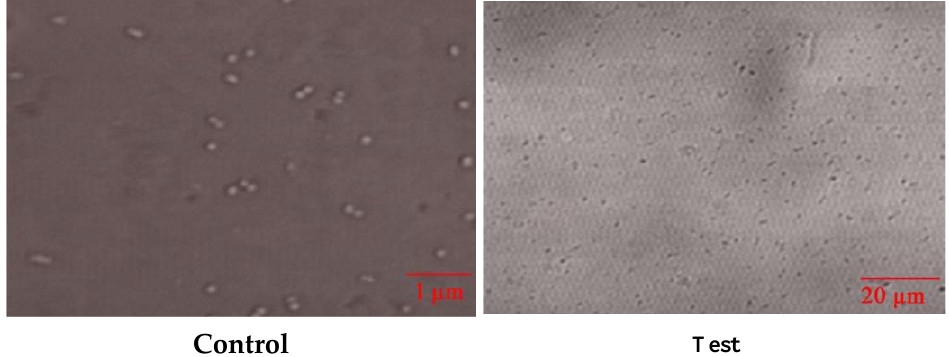
Figure 10. Confocal micrographs with control showing the presence of live cells, whereas the cells treated with Bacillus -mediated silver nanoparticles were